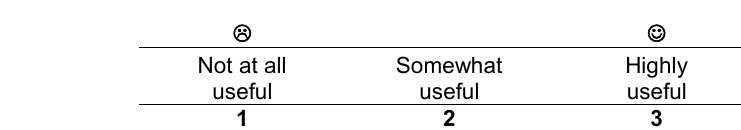
CONSORT Flowchart of Participant Enrollment, Allocation, Data Collection and Analysis